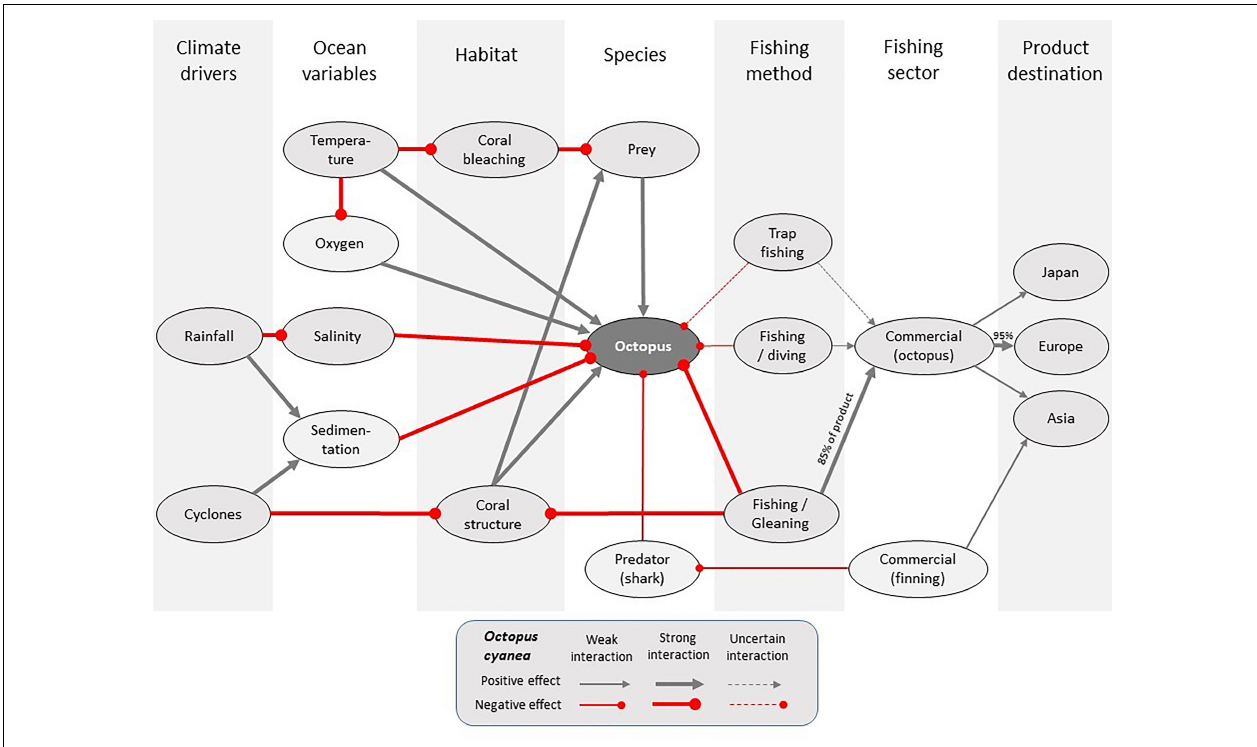
FIGURE 8 | Formalized octopus model showing qualitative interactions (negative and positive). This formalized model with complete feedback system would form the basis of a qualitative model enabling stability analysis to simulate alternative future climate change